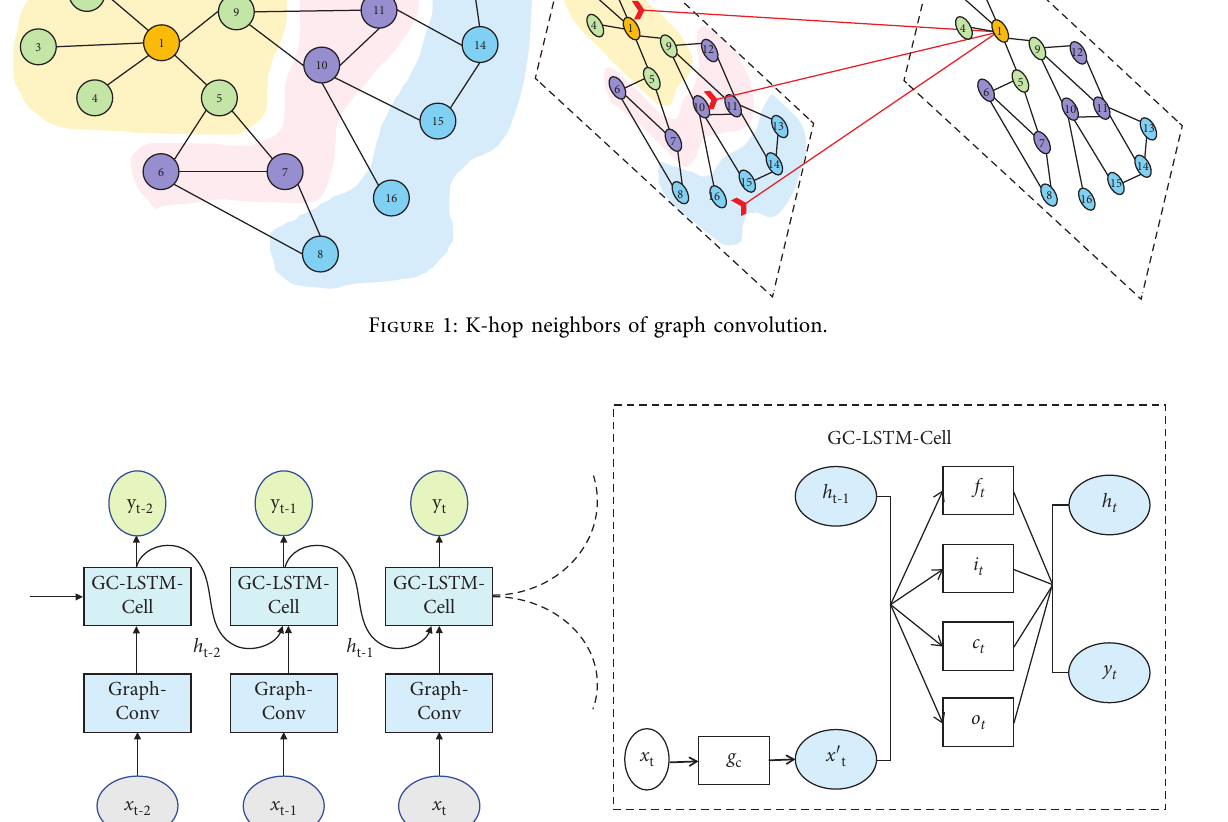
o t is the output gate,